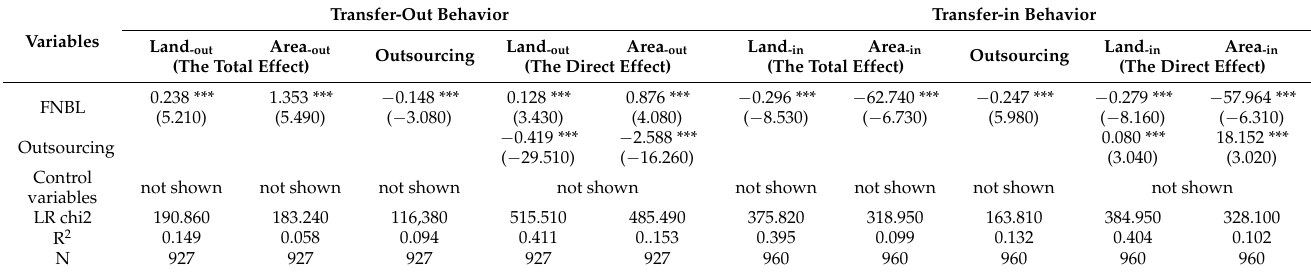
Table 4. The mediating effect of the agricultural production service outsourcing (APSO).